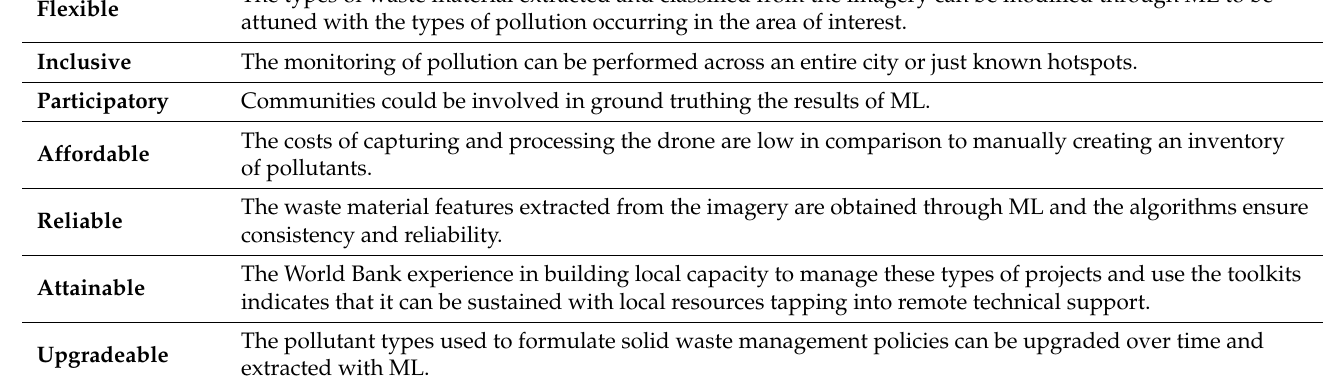
Table 7. FFP Approach Compliance